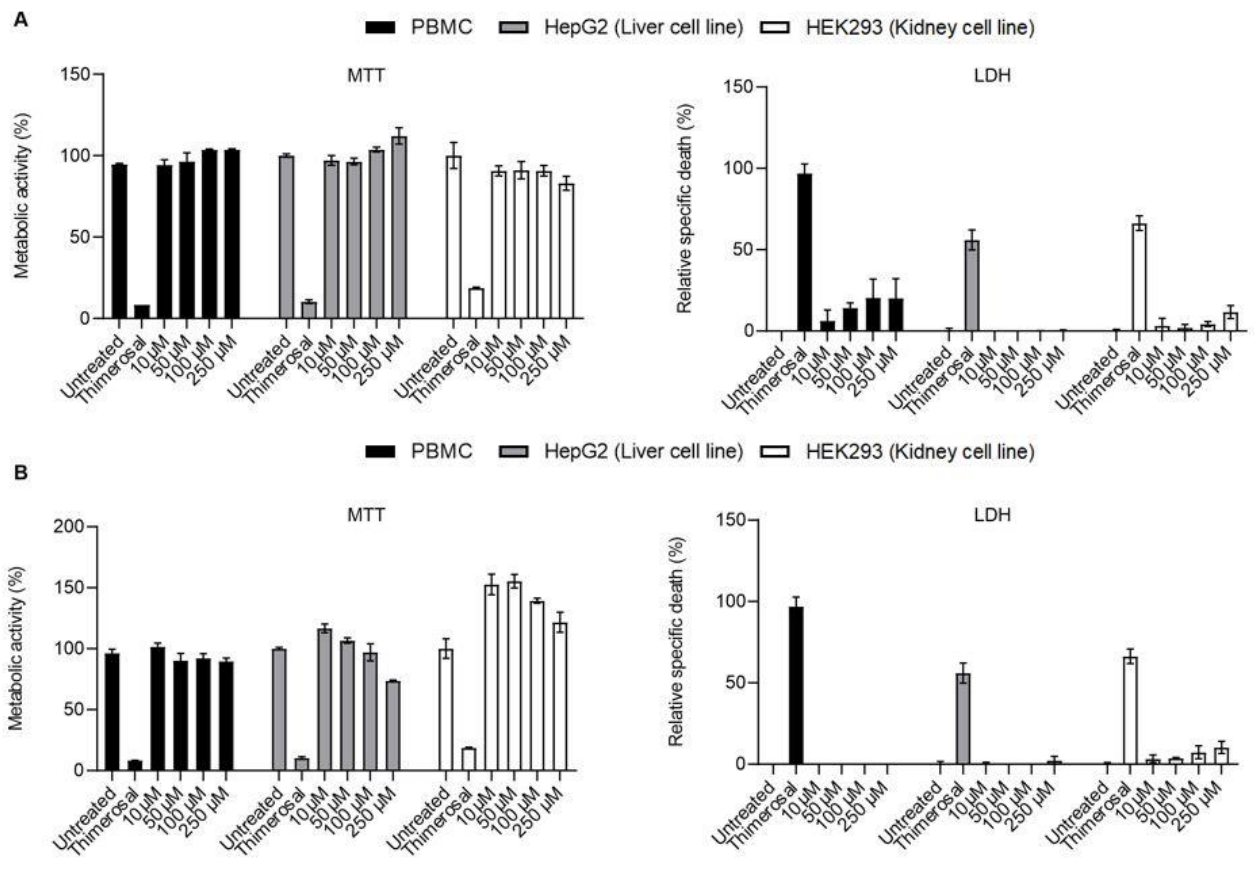
Figure 6. MTT ( left ) and LDH ( right ) results for PBMC (Black), Hep G2 (Grey), and HEK-293 (White) using high concentration (up to 250 µM) of KB-151 ( A ) and KB-208 ( B ). Y -axis for MTT graph shows the percentage of metabolic activity which is related to the cell viability, and for LDH graph, it shows the percentage of relative specific death which related to the cell toxicity. X -axis of both MT and LDH show different concentrations of KB-151 and KB-208 , Thimerosal at 100 µM as control toxicity (**** p ≤ 0.0001), and untreated control. Bars represent mean ± SD, and N = 3.